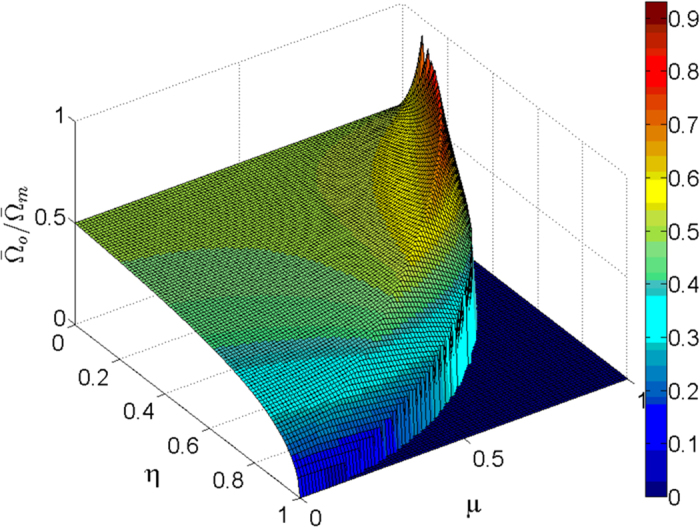
The ratio  versus η and μ, we impose  when η2 + μ2 > 1 in plotting the figure.